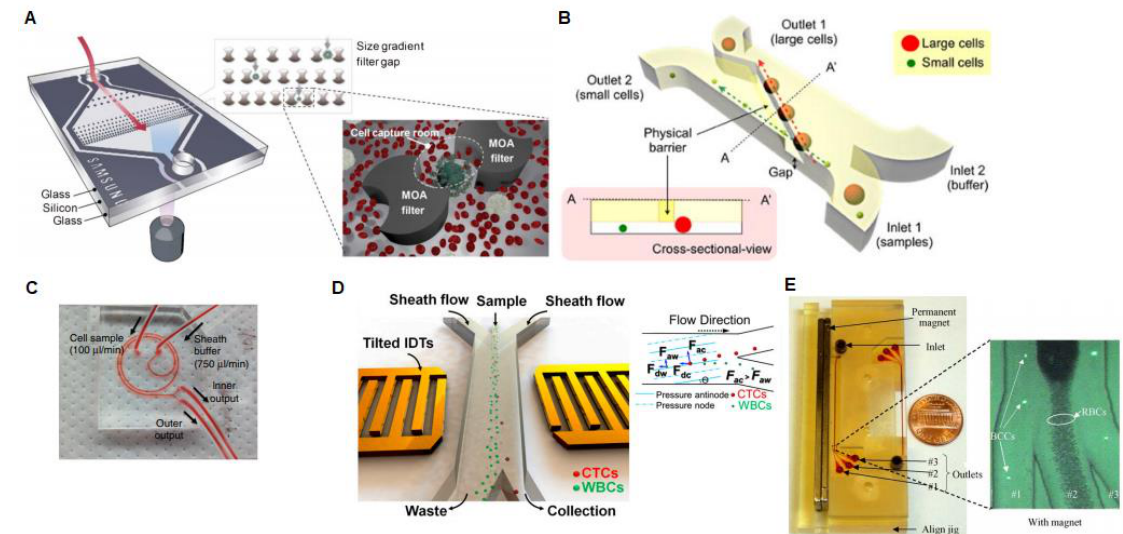
Figure 2. ( A ) Multi-obstacle architecture (MOA) size-gradient filter chip. For separation and cell clogging purposes, two different filters are integrated into the device respectively, the second one being mitigated by a “cell capture area” in-between [46]. Republished with permission of [Royal Society of Chemistry]; permission conveyed through Copyright Clearance Center, Inc. ( B ) The Microfluidic Cell Sorter (μFCS) is composed of a fluidic channel with two inlets and two outlets. In the microchannel, a gate is included diagonally for separating cells by their sizes. Thus, the small cells pass through the hole and are collected in outlet 2 by laminar flow. Meanwhile, the larger cancer cells pass through the barrier and are collected at another outlet [47]. Licensed under CC BY-NC International License. The final, published version of this article is available at [48]. ( C ) This system is made of two-loop spirals with two inlets and outlets with a radius of 10 mm, approximately. The microchannel width is 500 μm and outlet bifurcation is designed to be optimum between 150 and 350 μm. The device separates the cells based on their size using hydrodynamic forces [53]. Reprinted by permission from Springer Nature Customer Service Centre GmbH: on behalf of Cancer Research UK: [Nature Protocols], Copyright (2015) (doi:10.1038/nprot.2016.003). ( D ) Schematic of the working principle of tilted angle standing surface acoustic waves (taSSAW) microfluidic device for cancer cell isolation. In this platform, the larger CTCs experience a bigger acoustic radiation force (Fac) than WBCs (Faw). Consequently, CTCs suffer a greater vertical displacement than WBCs. Fdc and Fdw represent the drag force experienced by CTCs and WBCs. Copyright (2015) National Academy of Sciences [54]. ( E ) Continuous paramagnetic capture (PMC) microseparator device, where fluorescent breast cancer cell lines (BCCs) pass through the microchannel at a flow velocity of around 0.05 mm / s with an external magnetic alteration of 0.2 T. The separation is achieved based on the native magnetic properties of cells and can separate 94.8% of breast cancer cells. Reprinted with the permission of the publisher (Taylor & Francis Ltd.)